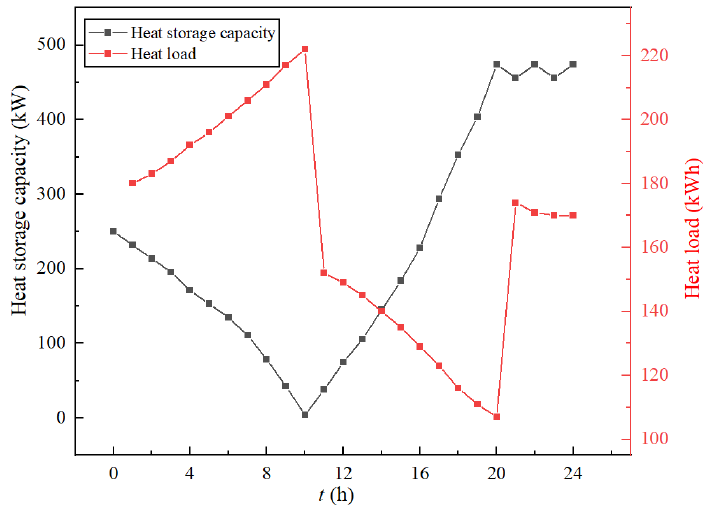
Figure 10. Heat storage capacity and heating load in each period when the objective function is system COP.